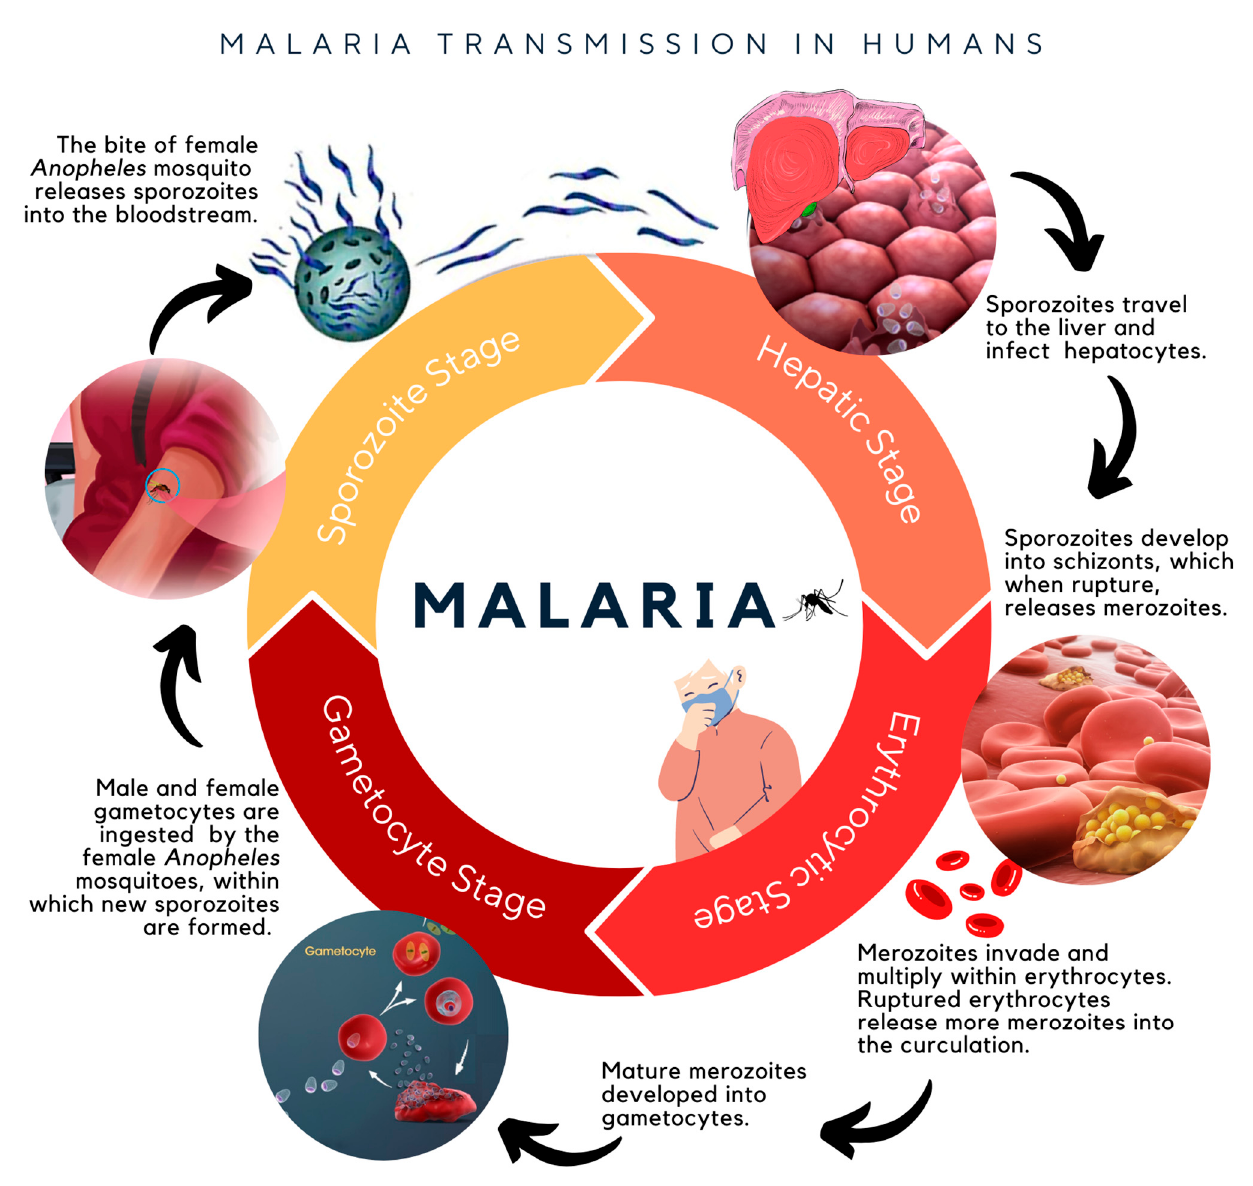
Figure 1. The life cycle of the Plasmodium parasite, beginning from the infection of sporozoites released by the bite of a female Anopheles mosquito into the circulatory system of humans [1,4]. Recent statistical data from the World Health Organization (WHO) indicate that 1.7